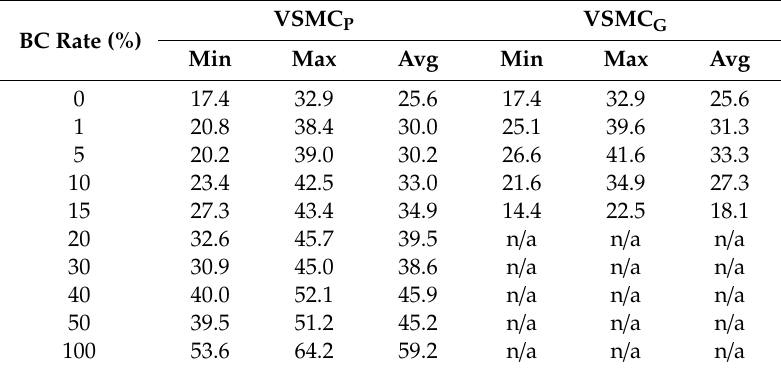
Figure 1. Time-domain reflectometer ( TDR) waves obtained from samples containing different granular biochar (BC G ) rates (VSMC was trying to be maintained closer to the field capacity of 30%). Up left: 0%; down left: 5%; up right: 50%; down right: 100%. Y-axis is wave amplitude (mV) and X-axis is travel time (nS). Two vertical lines in down left figures shows the two-way travel time of the electromagnetic (EM) wave along the 10 cm probe and was used to calculate the EM wave velocity and then dielectric constant of bulk soil ( K b ) and volumetric soil moisture content (VSMC). Detailed analysis of this wave propagation and calculation can be found in Topp et al. (1980) [8]. Table 3. Volumetric soil moisture contents (VSMCs) measured using the standard method (M-0) for each BC:soil mixture of both powdered (BC P ) and granular (BC G )